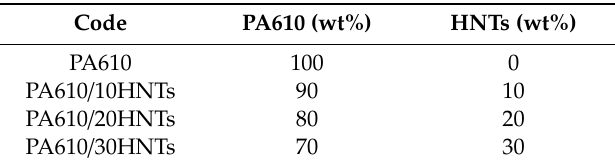
Table 1. Summary of compositions according to the weight percentage content (wt%) of polyamide 610 (PA610) and halloysite nanotubes